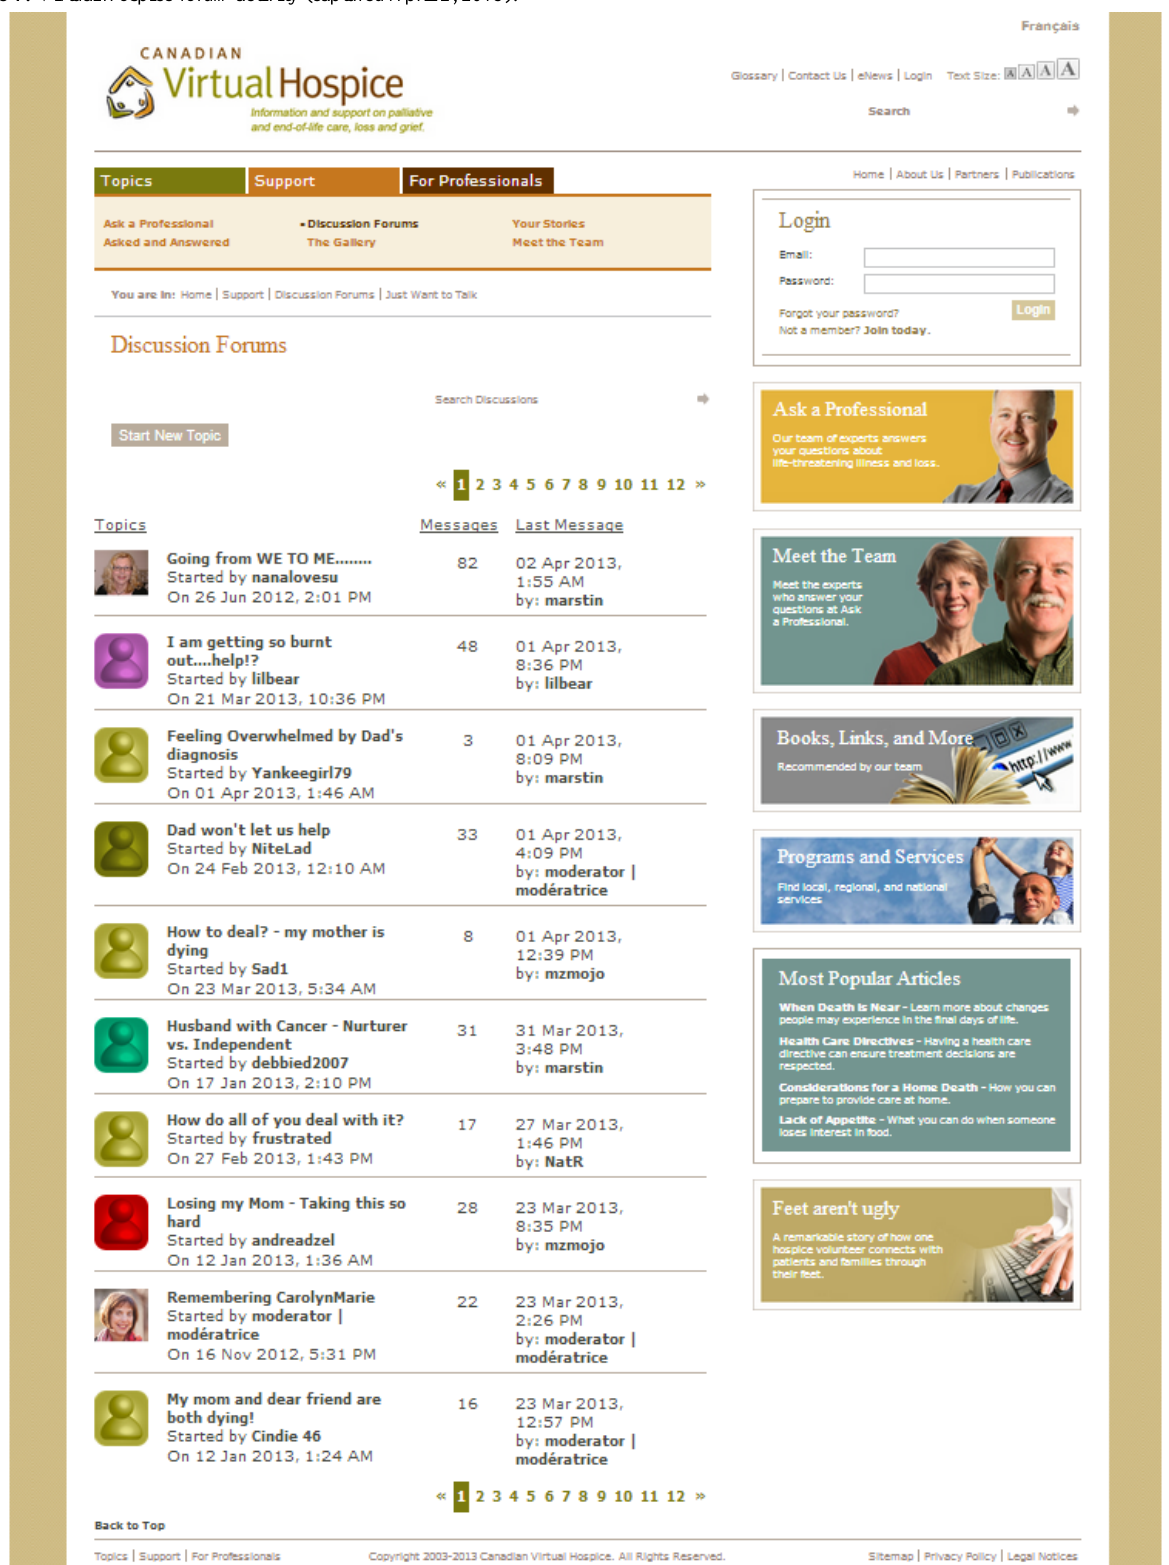
Figure 1. Virtual Hospice forum activity (captured April 2,